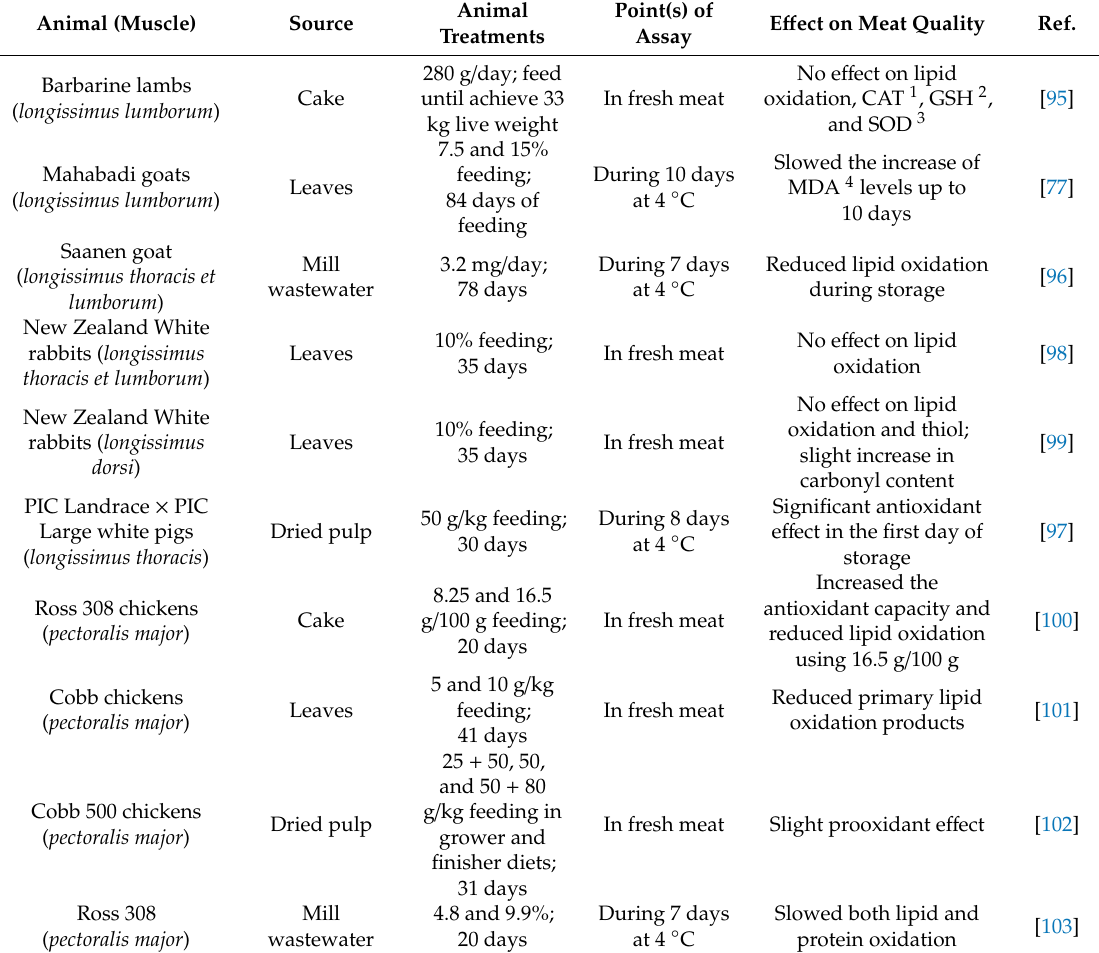
Table 5. Antioxidant of Olea europaea polyphenols as feed supplements in fresh meat. Animal (Muscle) Source